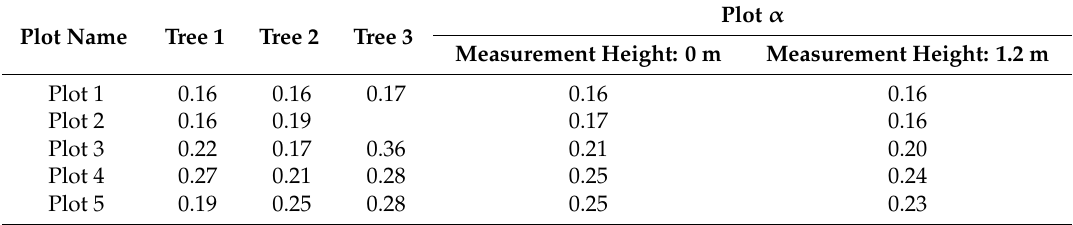
Table 4. The α of the harvested trees estimated via the destructive method with a measurement height of 0 m in each plot. The α of each plot was calculated by using Equation (15) with measurement heights of 0 m and 1.2